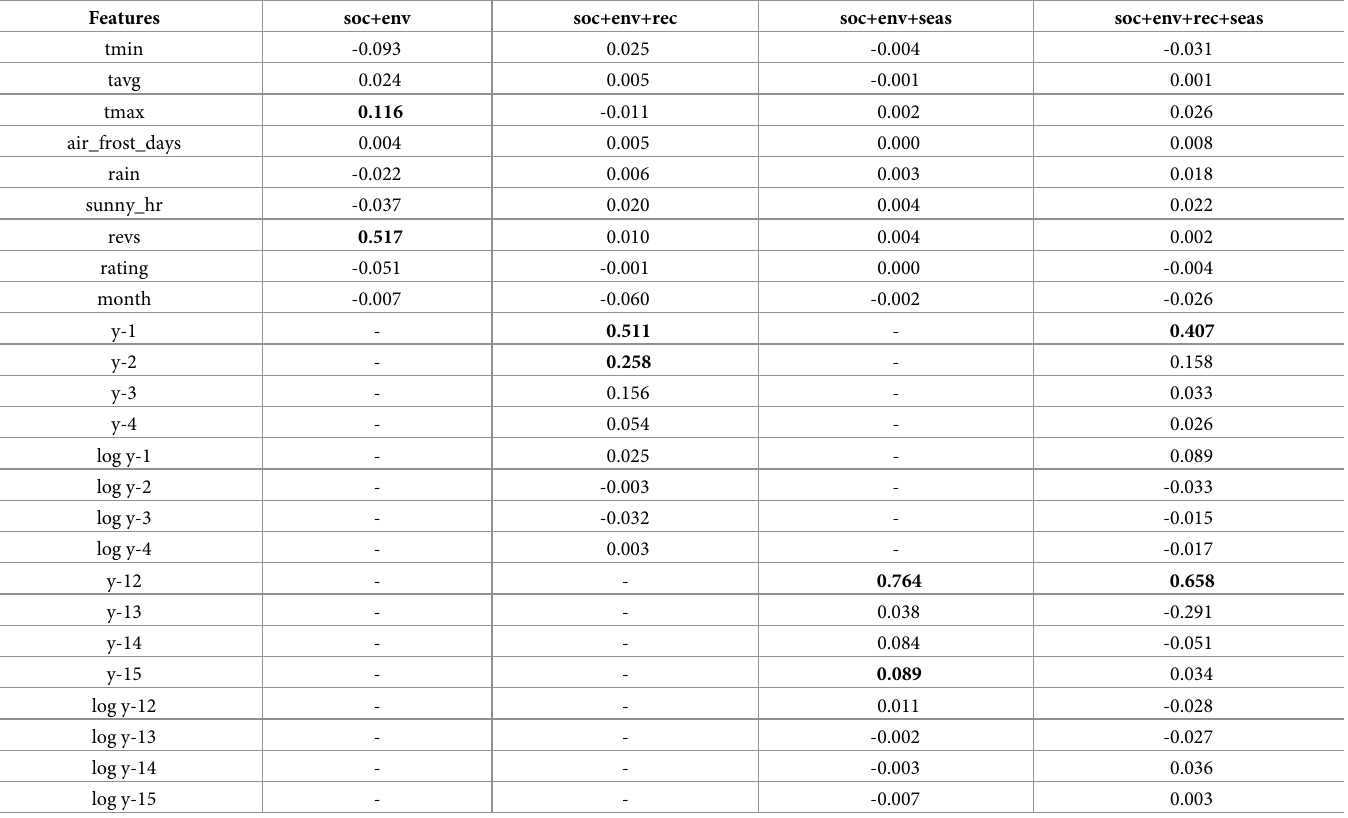
Table 9. The coefficients of features of global (single) model for all 27 U.K museums adopting each time a different set of features: (I) only social media and environ- mental features (soc+env), (II) social media, environmental and recency features (soc+env+rec), (III) social media, environmental and seasonality features (soc+env +seas), (IV) complete feature set: Social media, environmental, seasonality and recency feature (soc+env+rec+seas). The bold face shows the top 2 features in each column.